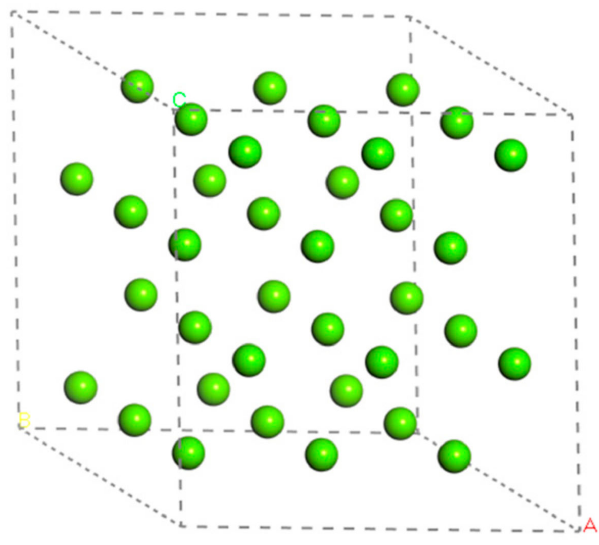
Figure 3. Mg supercell for band structure